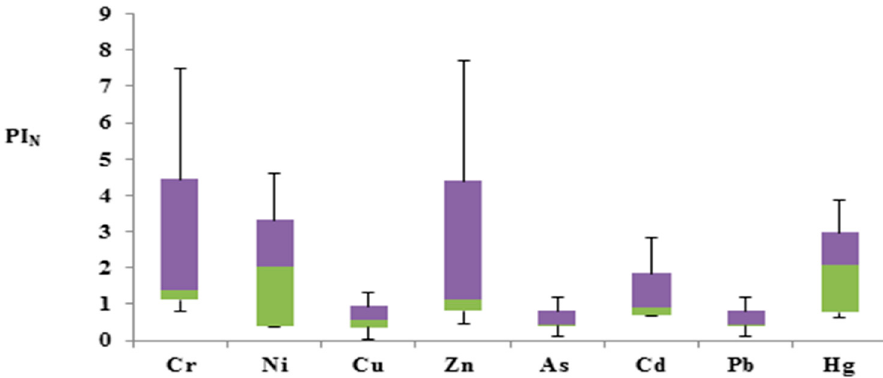
Figure 6. Boxplot of PI N (Green color= Quartile group 2, 25%), (Purple color= Quartile group 3, 25%)